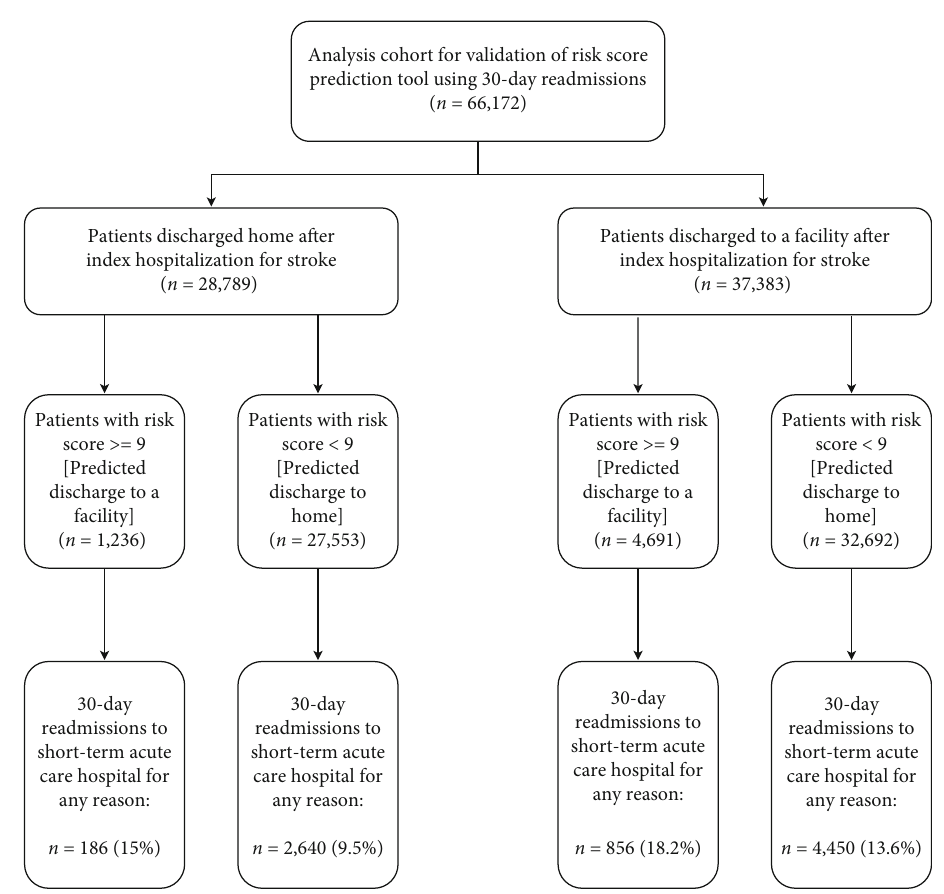
Figure 2: Flowchart of analysis cohort for validation of risk score prediction tool using 30-day